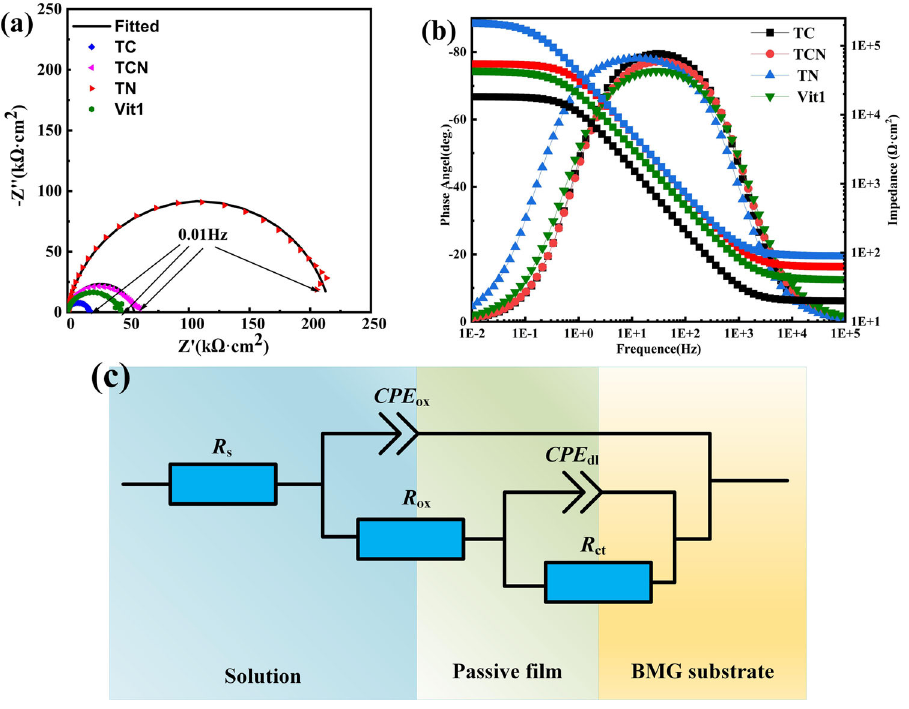
Fig. 3 EIS results of the samples under the OCP condition in 3.5 wt. % NaCl. a Nyquist, b Bode plots and c EEC used for fi tting the EIS experimental data. Table 2. Equivalent circuit fi tting parameters for EIS of the samples in 3.5 wt. % NaCl solution under OCP conditions. R s ( Ω cm 2